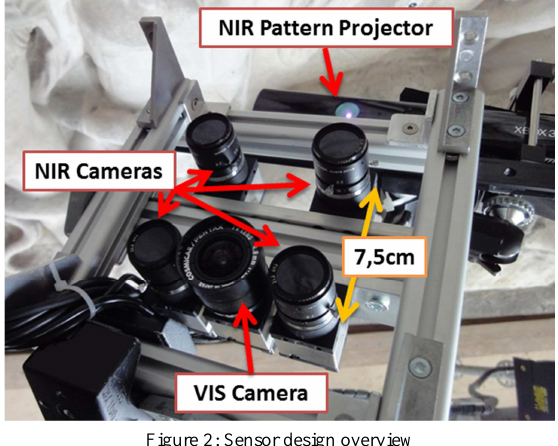
Figure 2: Sensor design overview